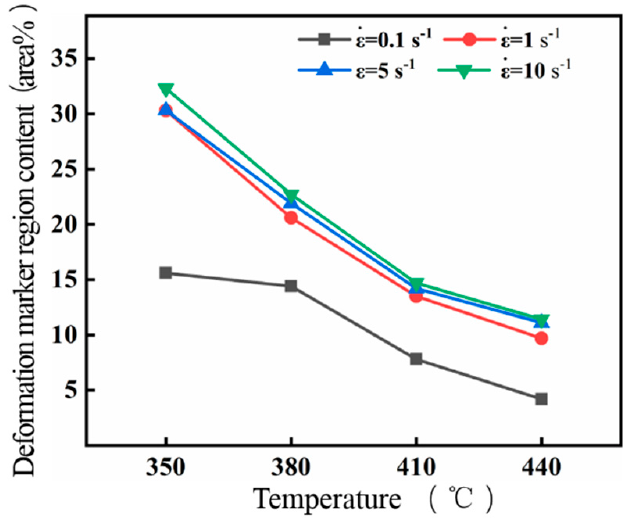
Figure 10. Statistics of the percentage of deformation marking area in the semi-solid CuSn10P1 alloy at different temperatures.